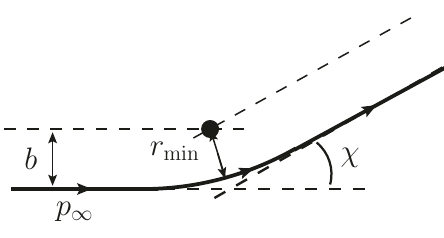
Figure 30 . The scattering angle in center of mass coordinates. The black circle denotes the center of mass. The thick solid line is a schematic representation of the trajectory, with (cid:31) being the angle of de(cid:13)ection in the (cid:12)nal